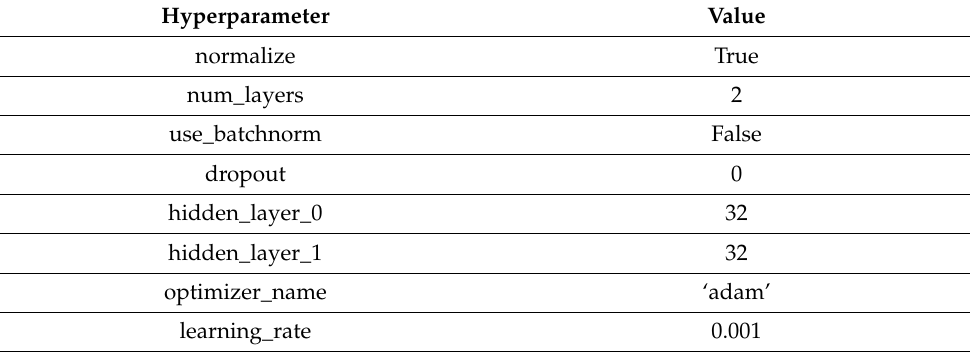
Table 3. Training